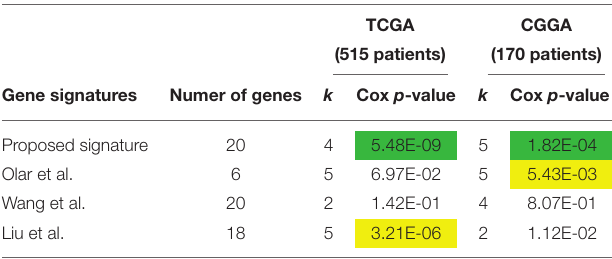
TABLE 2 | Prognostic performance of different gene signature panels related to